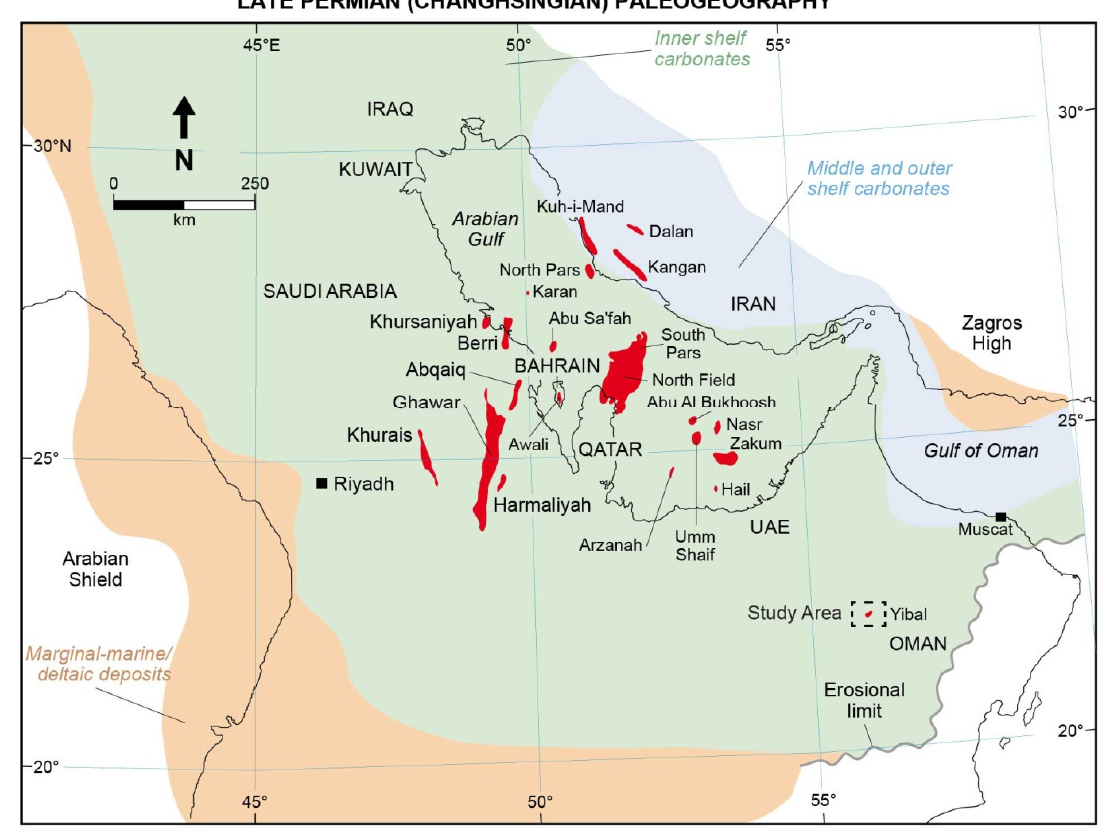
Figure 2. Paleogeographic map of the Arabian Gulf area during the Late Permian showing the location of the study area in Oman and major hydrocarbon fields (red) within the Khuff reservoirs (blue and green) (modified from Maurer et al., [27], after Ziegler, [28] and Koehrer et al., [29]).